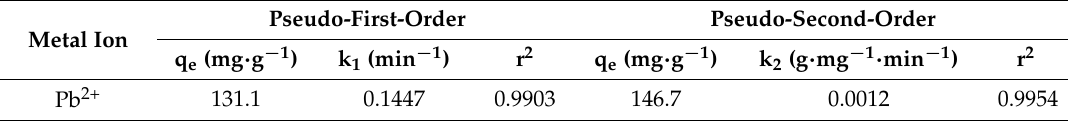
Table 3. Parameters of kinetic models for Pb(II) adsorption onto g-PAM/OVerm.